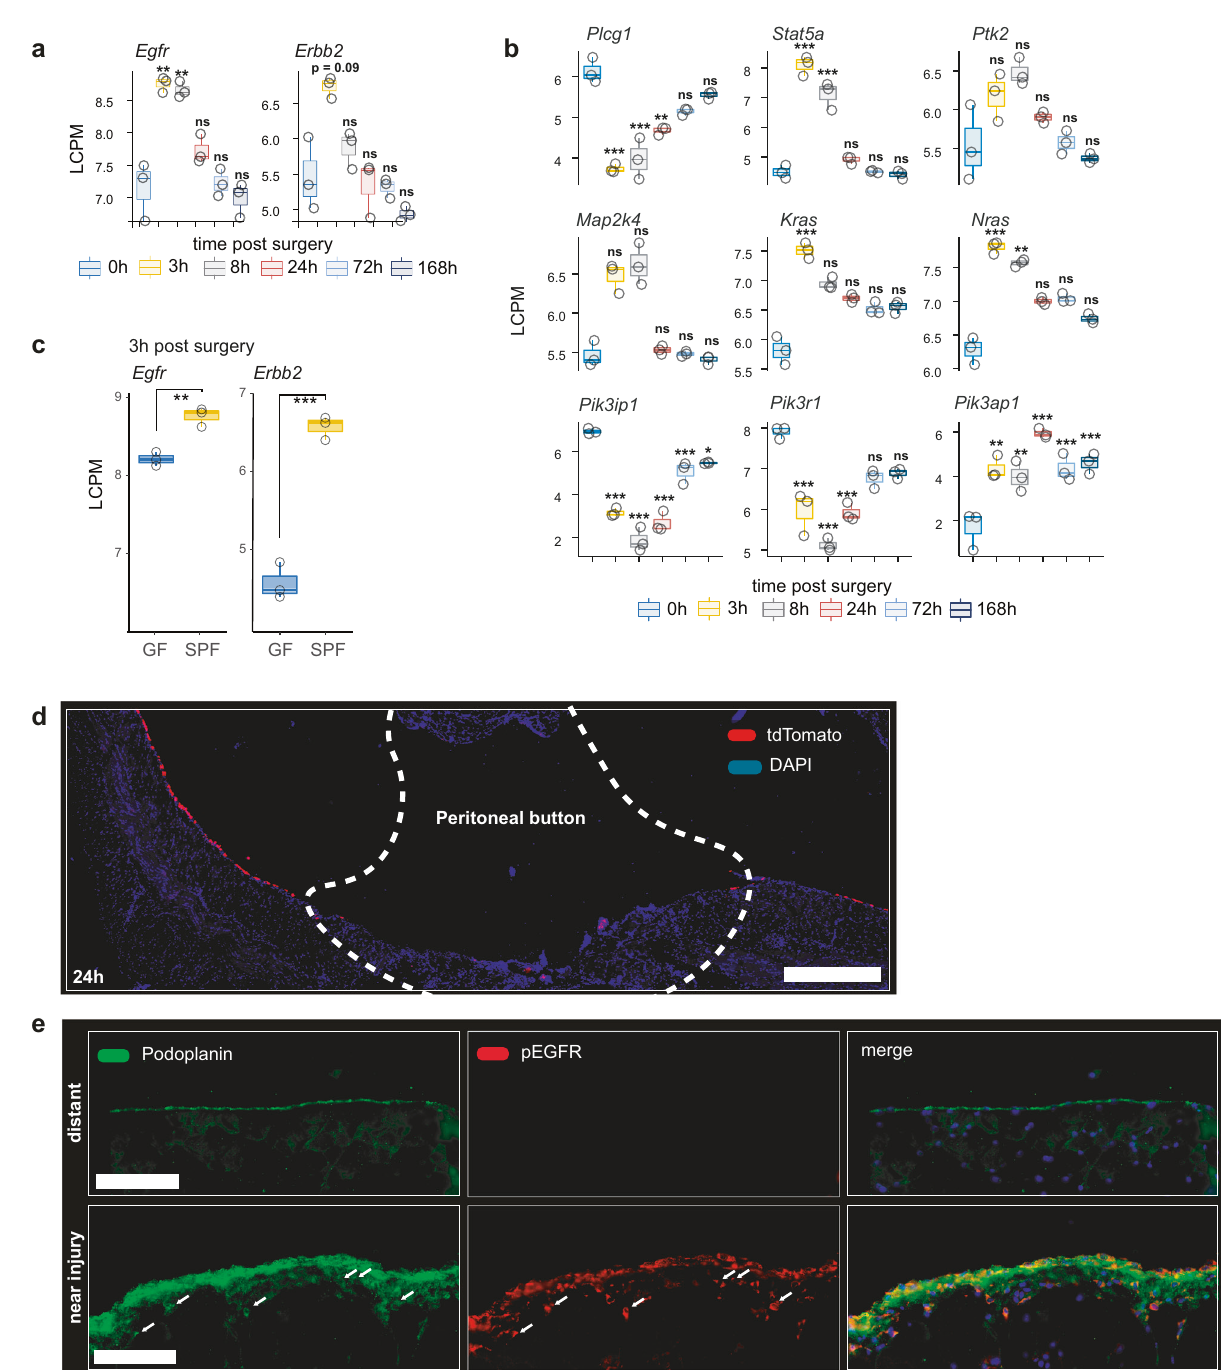
Fig. 4 Mesothelial cell activation is driven by receptor tyrosine kinases of the ERBB family. a Epidermal growth factor receptor ( Egfr ) and Erbb2 were the main genes encoding for receptor kinases differentially expressed (log count per million, LCPM) over time. b Genes downstream of Egfr and Erbb2 are differentially expressed as well (inhibitory genes are repressed). c Expression of Egfr and Erbb2 genes in mesothelium isolated from germ-free (GF) and speci fi c-pathogen-free (SPF) mice 3 h after sterile injury in combination with bacterial contamination (PB + CLP). Data ( a – c ) is representative of n = 3 independent animals examined in one experiment. Data are presented as individual values and boxplots (median, fi rst and third quartile) d Peritoneal button, 24 h after injury of Wt1 CreERT2 Rosa26 tdTomato reporter mice that were treated with Tamoxifen 2 weeks prior to experiment. Scale bar 500 µ m. Data represents n = 3 animals of 2 independent experiments. e Peritoneal biopsies from healthy mice and from mice 3 days after surgery (PB + CLP). Scale bar 50 µ m. Data represents n = 8 animals of 2 independent experiments. Differential expression testing according to the linear modeling as described in the methods section. * P < 0.05, ** P < 0.01, *** P < 0.001, n.s. P ≥ 0.05. Exact p -values are provided in Supplementary Data 1. Raw data were deposited at gene expression omnibus